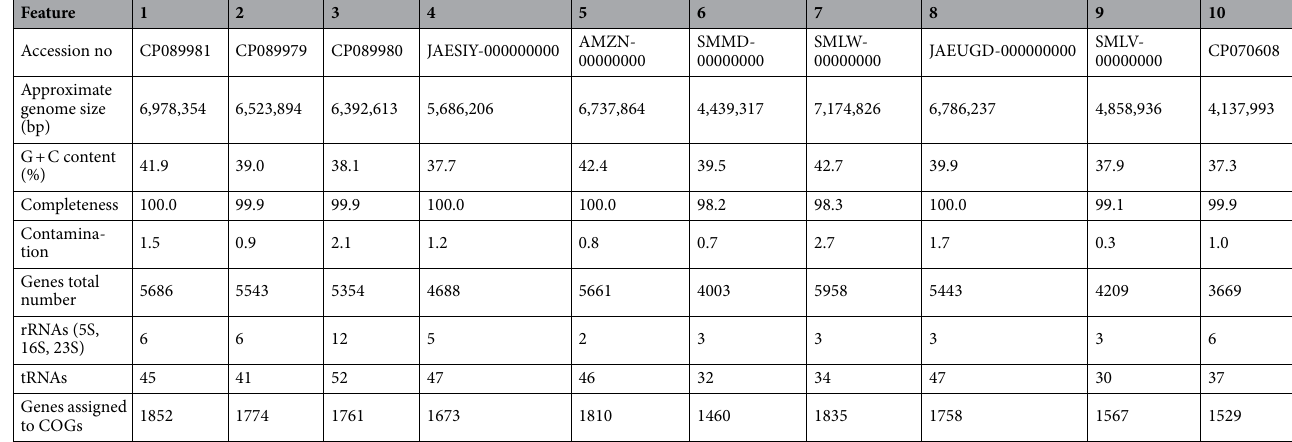
Table 4. Comparative genome properties of three novel strains with existing members in genus Fulvivirga . Taxa: 1, SS9-22 T ; 2, W9P-11 T ; 3, SW1-E11 T ; 4, F. sediminis 2943 T ; 5, F. imtechensis JCM 17390 T ; 6, F. aurantia S481 T . COG: Clusters of Orthologous Groups of